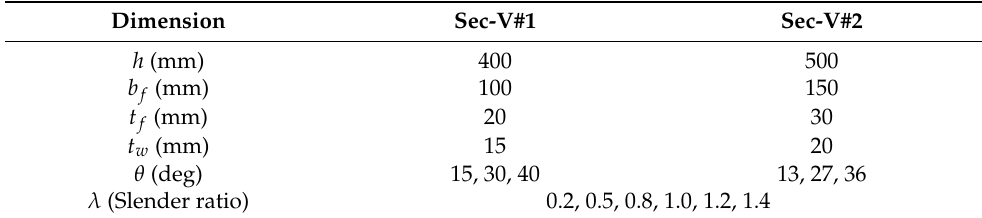
Table 3. Dimension of Sections and Parameters.